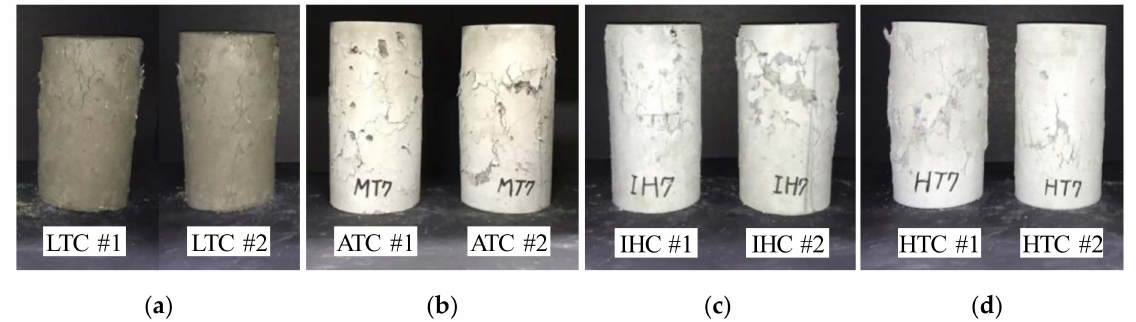
Figure 10. Appearance of cylinders after compression tests at 15 h: ( a ) LTC specimens; ( b ) ATC specimens; ( c ) IHC specimens; ( d ) HTC specimens.